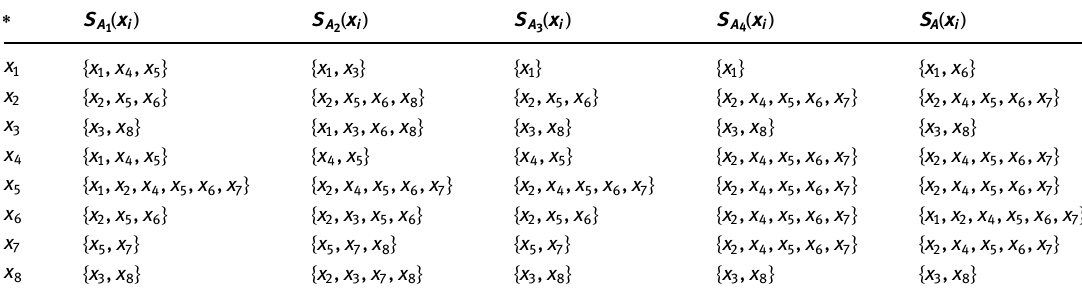
Table 4: The similarity classes of elements in Example